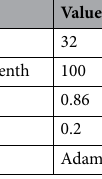
Table 2. Parameter